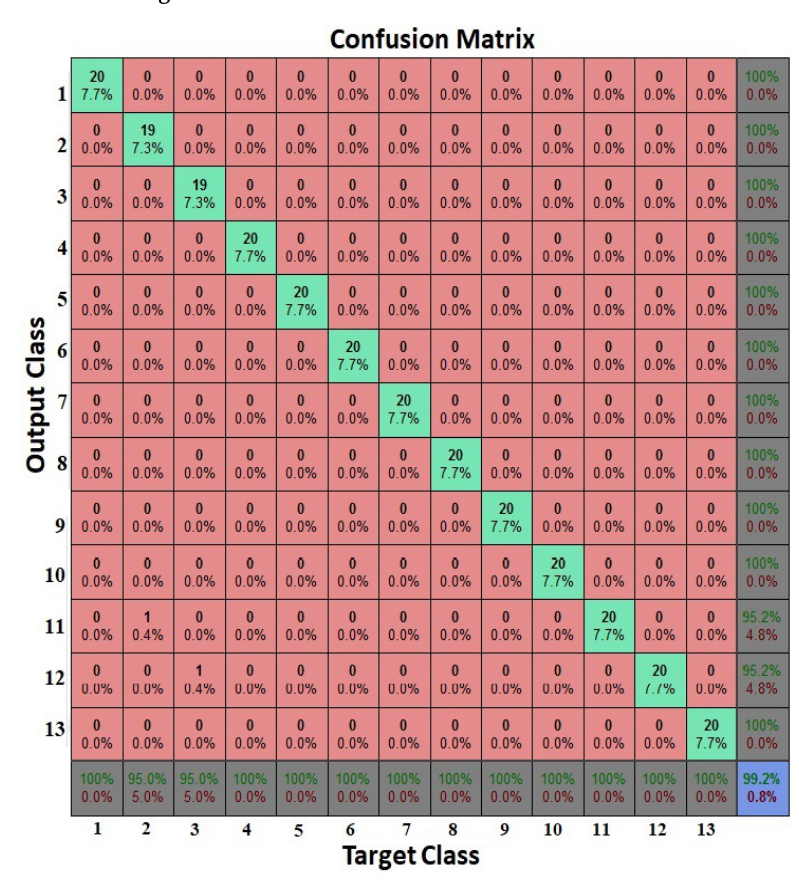
Figure 10. Network architecture and size in MATLAB.